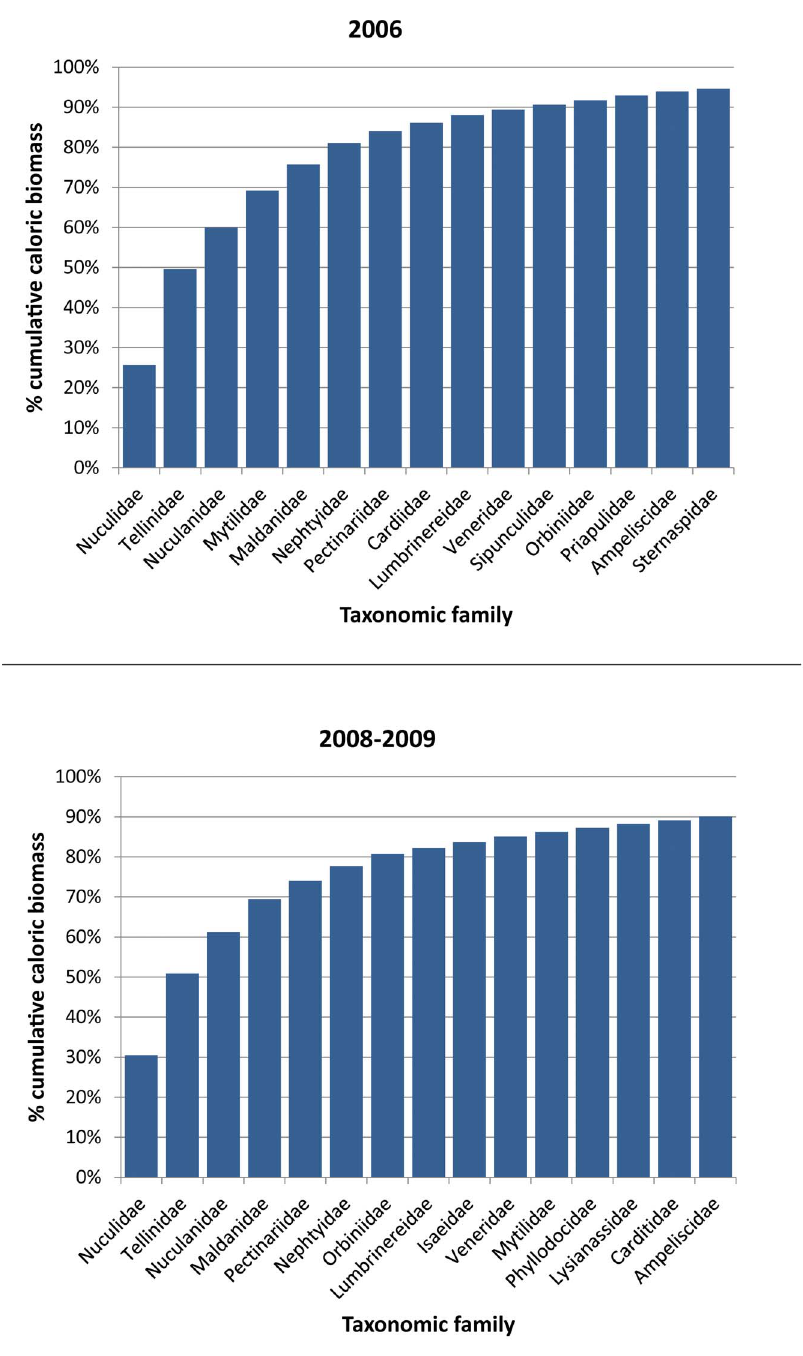
Figure 3. Percent cumulative caloric biomass within benthic sampling areas in 2006 and 2008–2009. Dominant taxa from each sampling period were identified by the minimum number of top-ranked taxa comprising at least 80% of the cumulative caloric biomass (only the first 15 ranked taxa are shown).